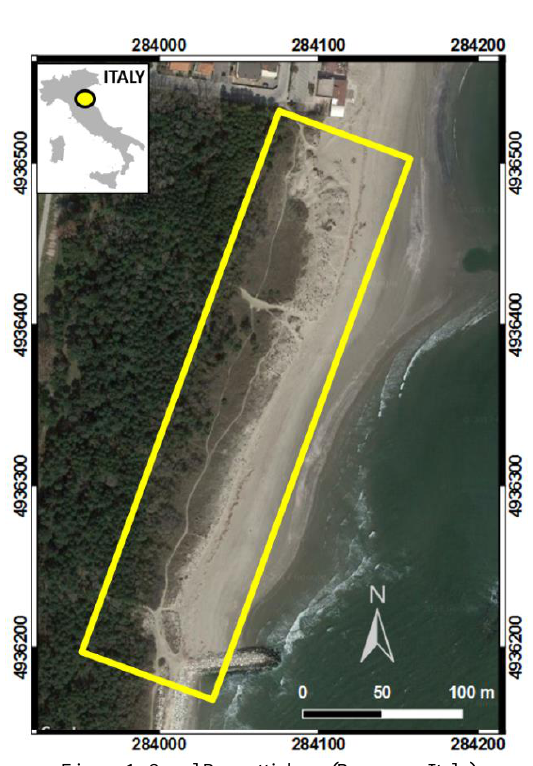
Figure 1. Casal Borsetti dune (Ravenna,